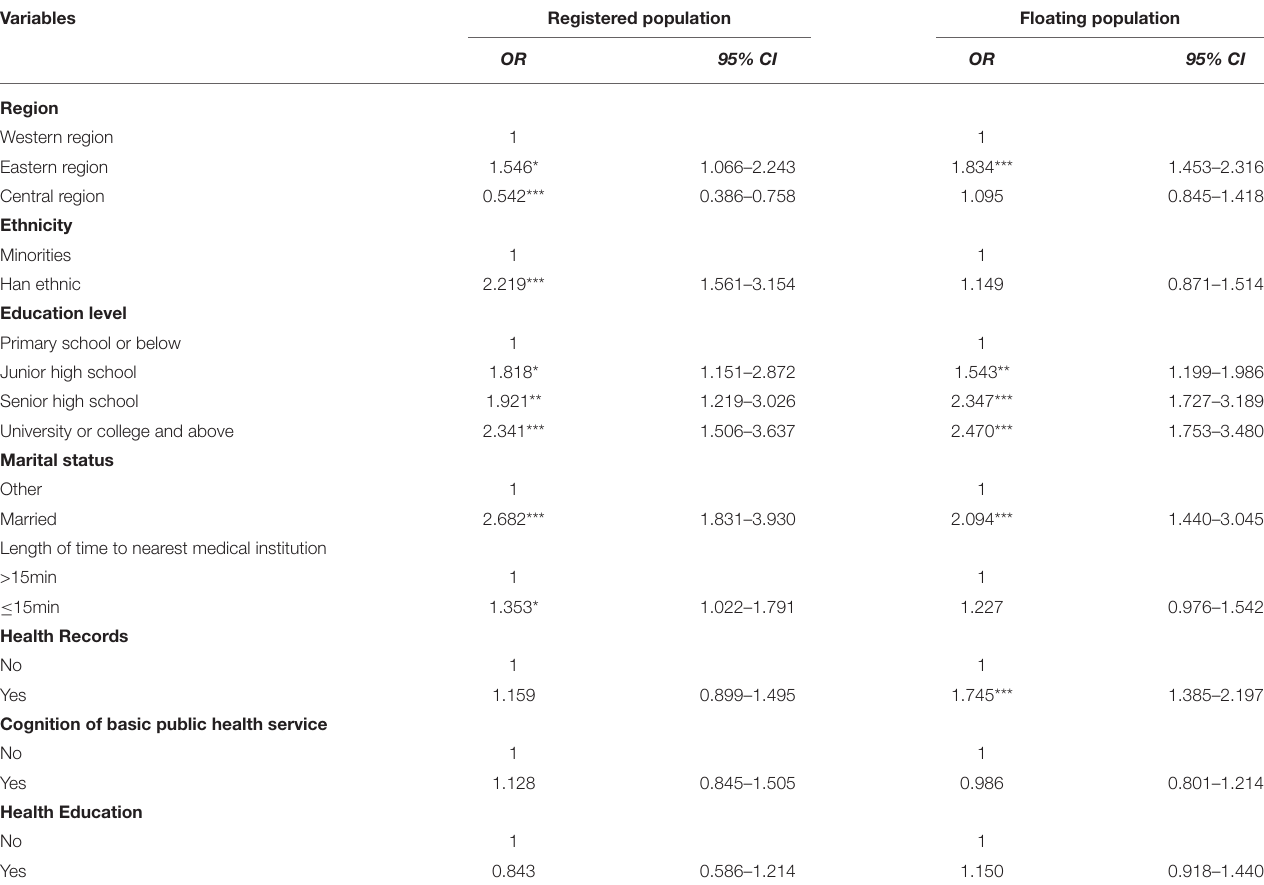
TABLE 4 | Logistic regression analysis of the influencing factors of complete